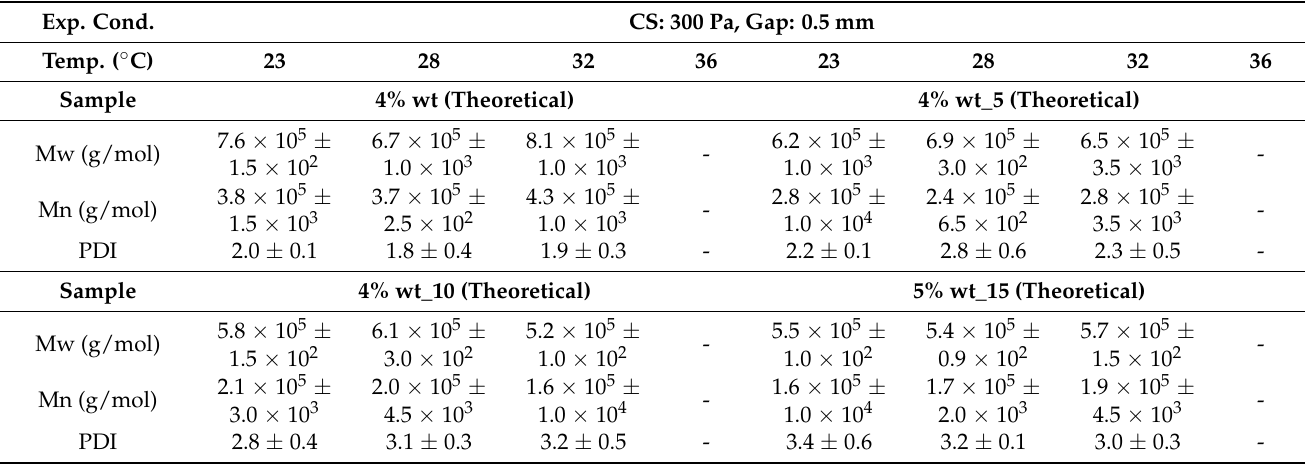
Table 5. Molecular weights and their polydispersity index for 4% wt samples with different thermo- mechanical